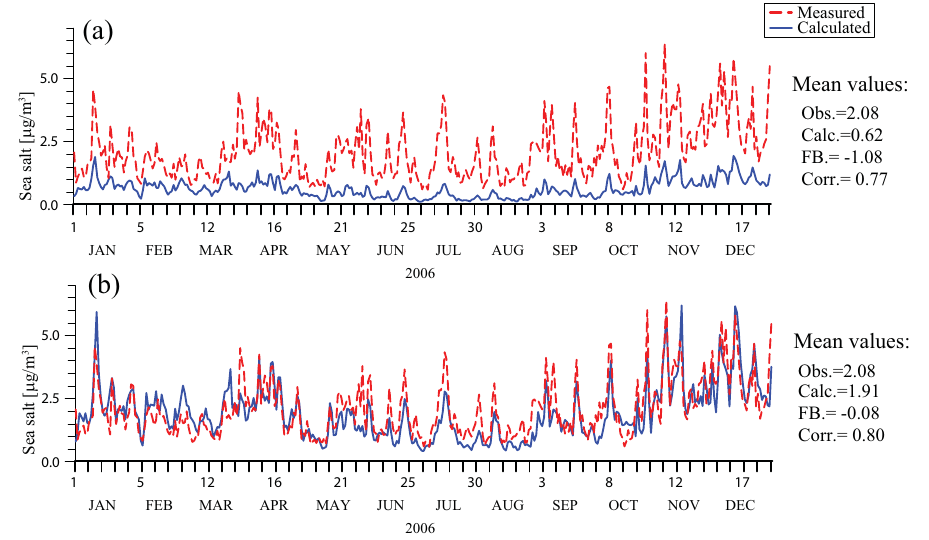
Fig. 9. Evaluation of the sea-salt simulations from DEHM based on (a) a simplified parameterisation by Monahan et al. (1986), and (b) a combined source function based on Mårtensson et al. (2003) and Monahan et al. (1986) against observations from the EMEP monitoring network in the year 2006.